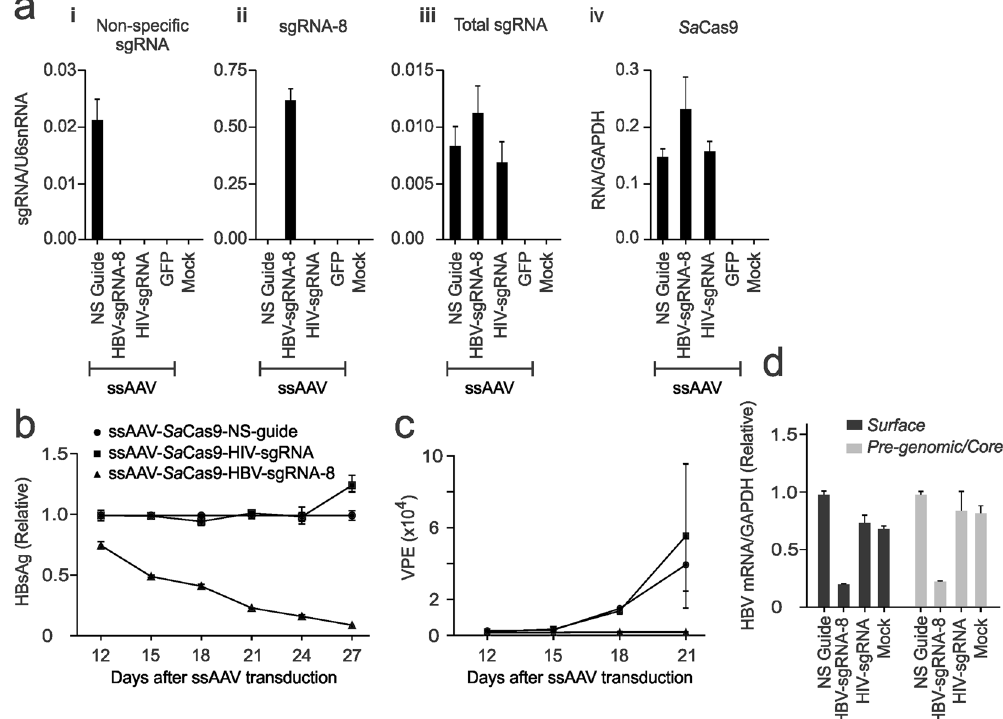
Figure 2. Inhibition of markers of HBV replication following delivery of SaCas9-sgRNA-8 with ssAAVs. ( a ) HepG2.2.15 cells were transduced with ssAAVs that encoded HBV-targeting sgRNA-8, a non-specific guide, HIV-targeting sgRNA or a GFP reporter. RNA was extracted 21 days after transduction and subjected to qRT- PCR. Primers were complementary to (i) sgRNA-8, (ii) the non-specific control sgRNA, (iii) all sgRNAs or (iv) SaCas9 sequences. ( b ) Concentrations of HBsAg were measured in the culture supernatants of cells that had been transduced with ssAAVs encoding SaCas9 and sgRNA-8, sgRNA targeting HIV or a non-specific sequence. Analysis was carried out over a time course of 27 days after transduction. ( c ) Assay of viral particle equivalents (VPEs) in culture supernatants of HepG2.2.15 cells after transduction with HBV-targeting and control ssAAVs. Cells were washed and measurements were based on qPCR carried out on extracts of culture supernatants taken from days 12 to 21 after transduction. ( d ) HBV RNA was measured in transduced cells at day 21 after transduction with the indicated ssAAVs. qRT-PCR was carried out with primers specific for surface ( S ) or pregenomic HBV RNA